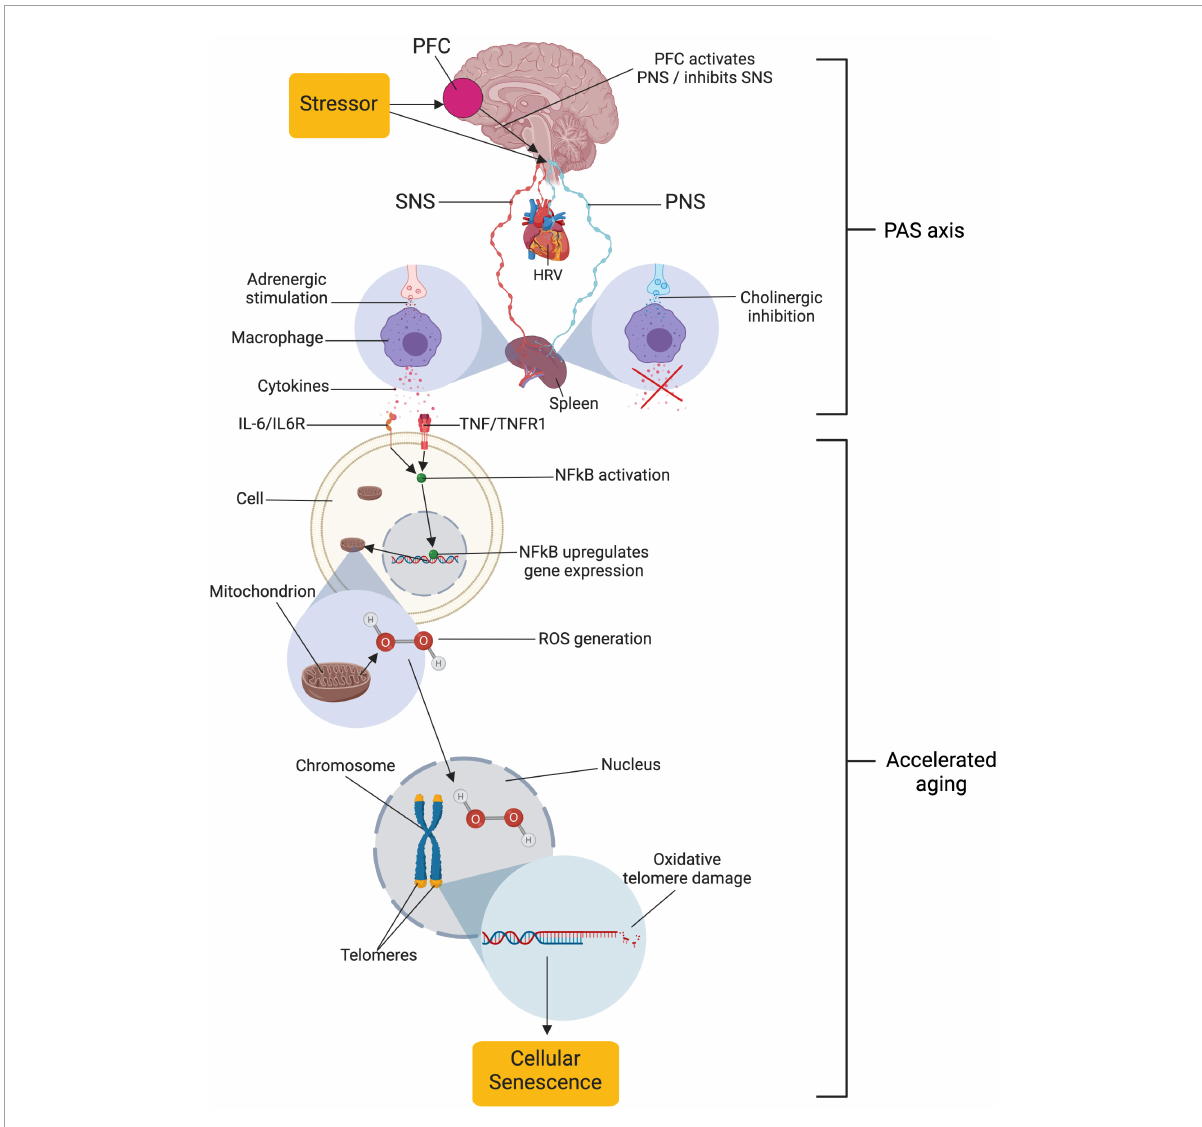
FIGURE1 Relationships proposed by the neuro-immuno-senescence integrative model (NISIM). The NISIM propose that the link between psychological stress and telomere length starts with (1) prefrontal capacity for increasing activity in the vagus nerve, (2) vagal input to the spleen modulating the inflammatory response, (3) subsequent inflammatory load increasing Nuclear Factor Kappa B (NFkB) activity and reactive oxygen species generation, and (4) the resulting oxidative damage to telomeres (Ask et al., 2018). PFC, prefrontal cortex; SNS, sympathetic nervous system; PNS, parasympathetic nervous system; HRV, heart rate variability; PAS axis, prefrontal cortex-autonomic nervous system-spleen axis; IL-6, interleukin 6; IL6R, IL6 receptor; TNF, tumor necrosis factor; TNFR1, TNF receptor 1; ROS, reactive oxygen species; HOOH, hydrogen peroxide. Created with